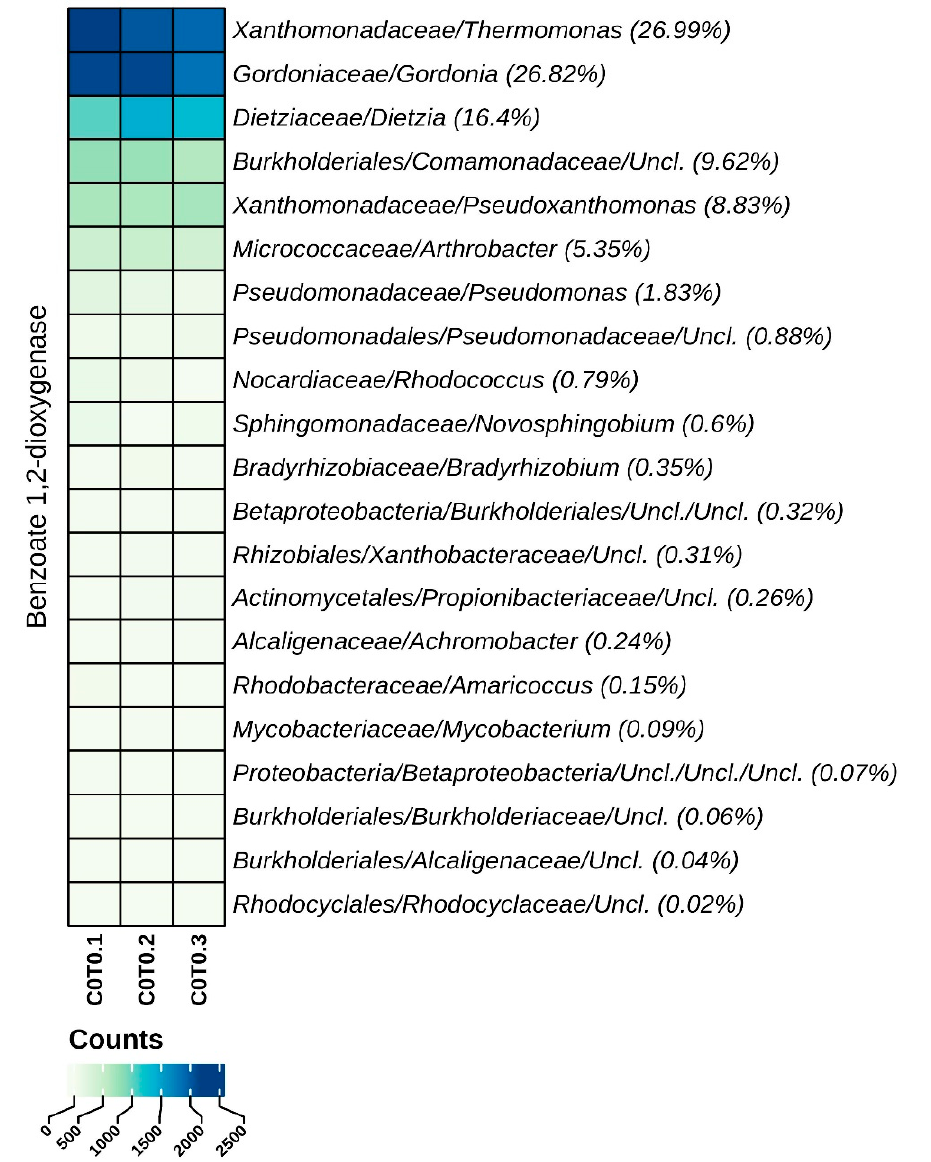
Figure 8. Functional Heatmaps of the Benzoate 1,2-dioxygenase contribution by identified ASVs aggregated at the Genus level, as inferred by PICRUSt2 in the three biological replicates. On rows, the nearest identified taxonomic level for each contributing ASV is reported, followed by its relative percentage contribution to the functional feature. Hierarchical clustering of columns was performed by Pearson correlation, based on Euclidean